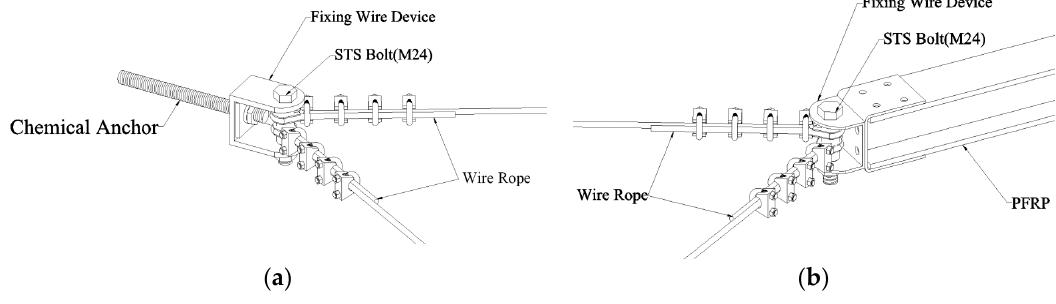
Figure 9. Connection of mooring system; ( a ) Between chemical anchor and cable; ( b ) Between PFRP member and cable.